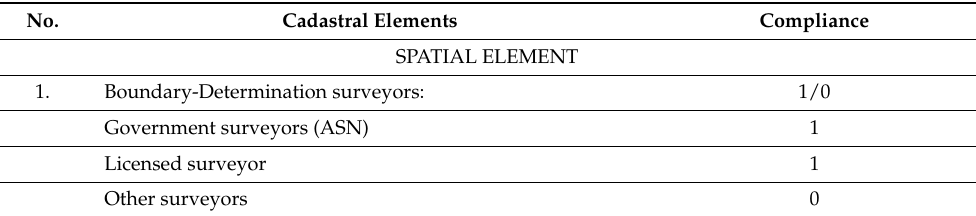
Figure 2. Stages of boundary determination in survey and mapping activities for purposes of physical data collection and processing consisting of legal elements (blue boxes 1, 2, 3) and spatial elements (red boxes 4, 5, 6) [12]. Table 2. Assessment of spatial element compliance level of spatial cadastre dataset on sporadic and systematic measurements